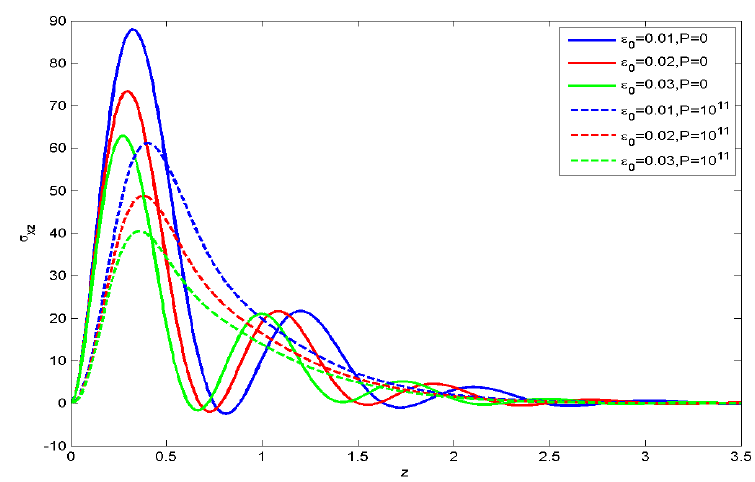
σ concerning z with electric field 0